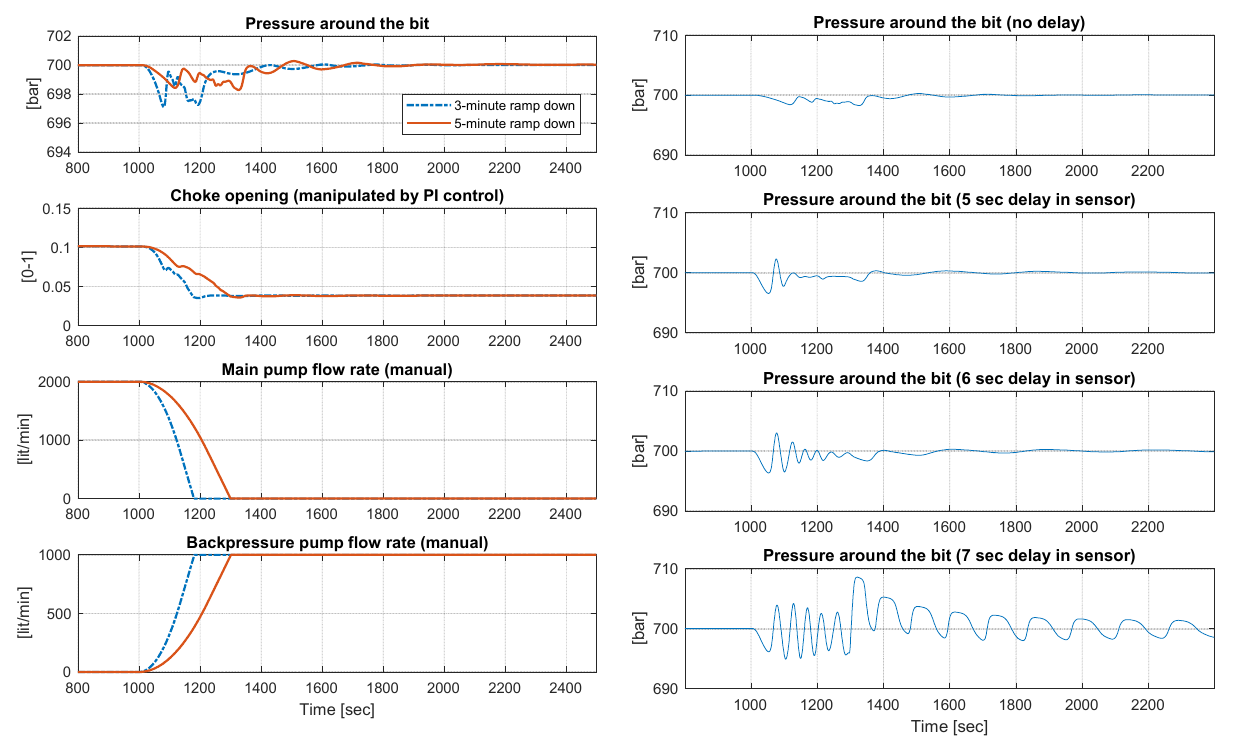
Figure 6: Pressure response while stopping the mud circulation with soft changes in the beginning of stopping circulation.